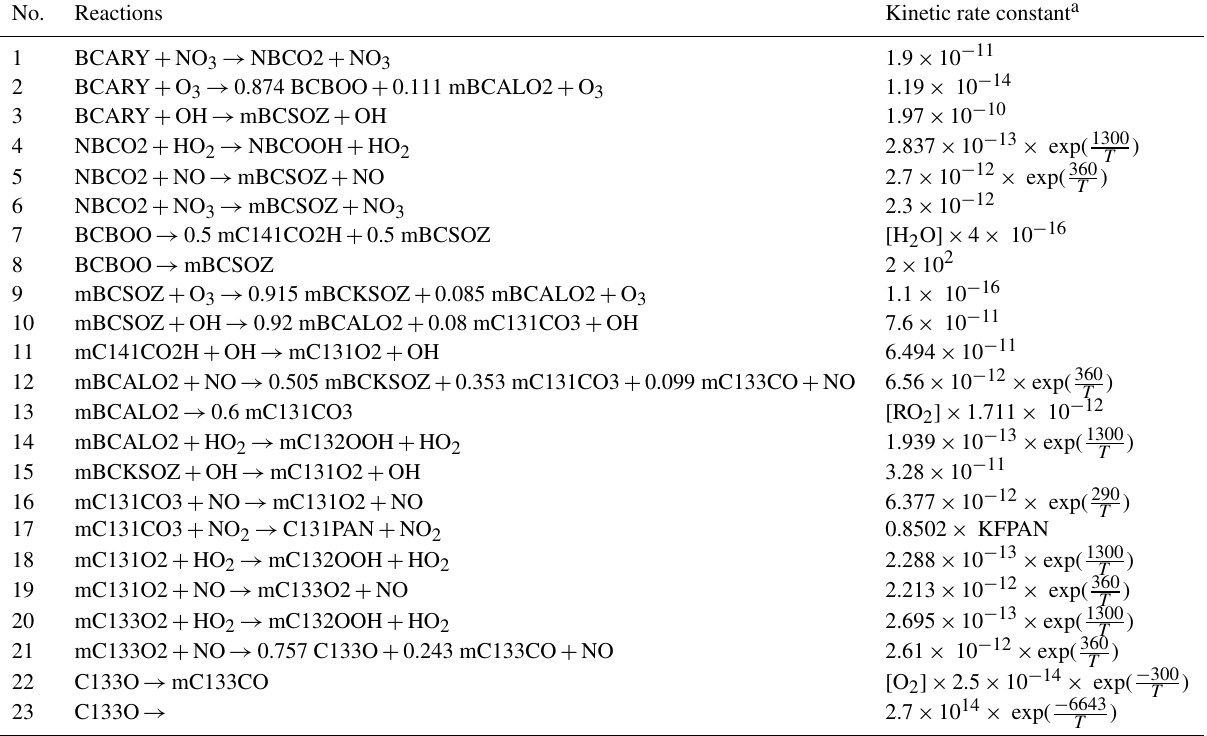
Table B2. Reaction list of the Rdc.